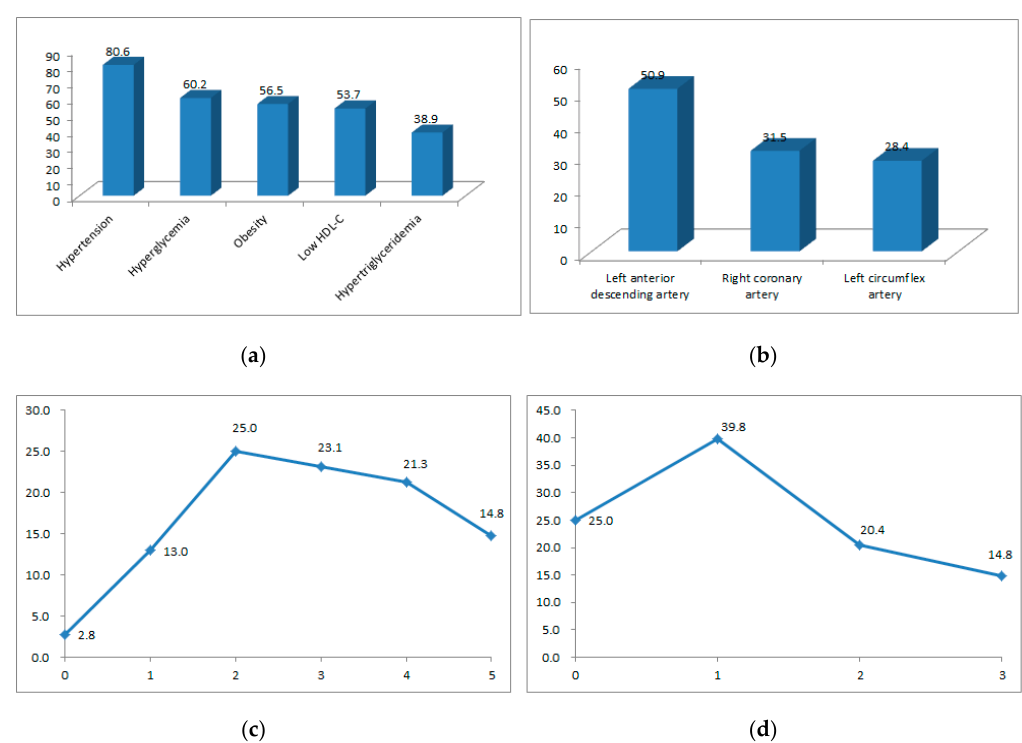
Figure 2. Characteristics of the metabolic syndrome and the severity of coronary artery disease; ( a ) Prevalence of metabolic syndrome components; ( b ) prevalence of coronary artery stenosis; ( c ) proportion of metabolic syndrome score; ( d ) proportion of coronary artery disease severity